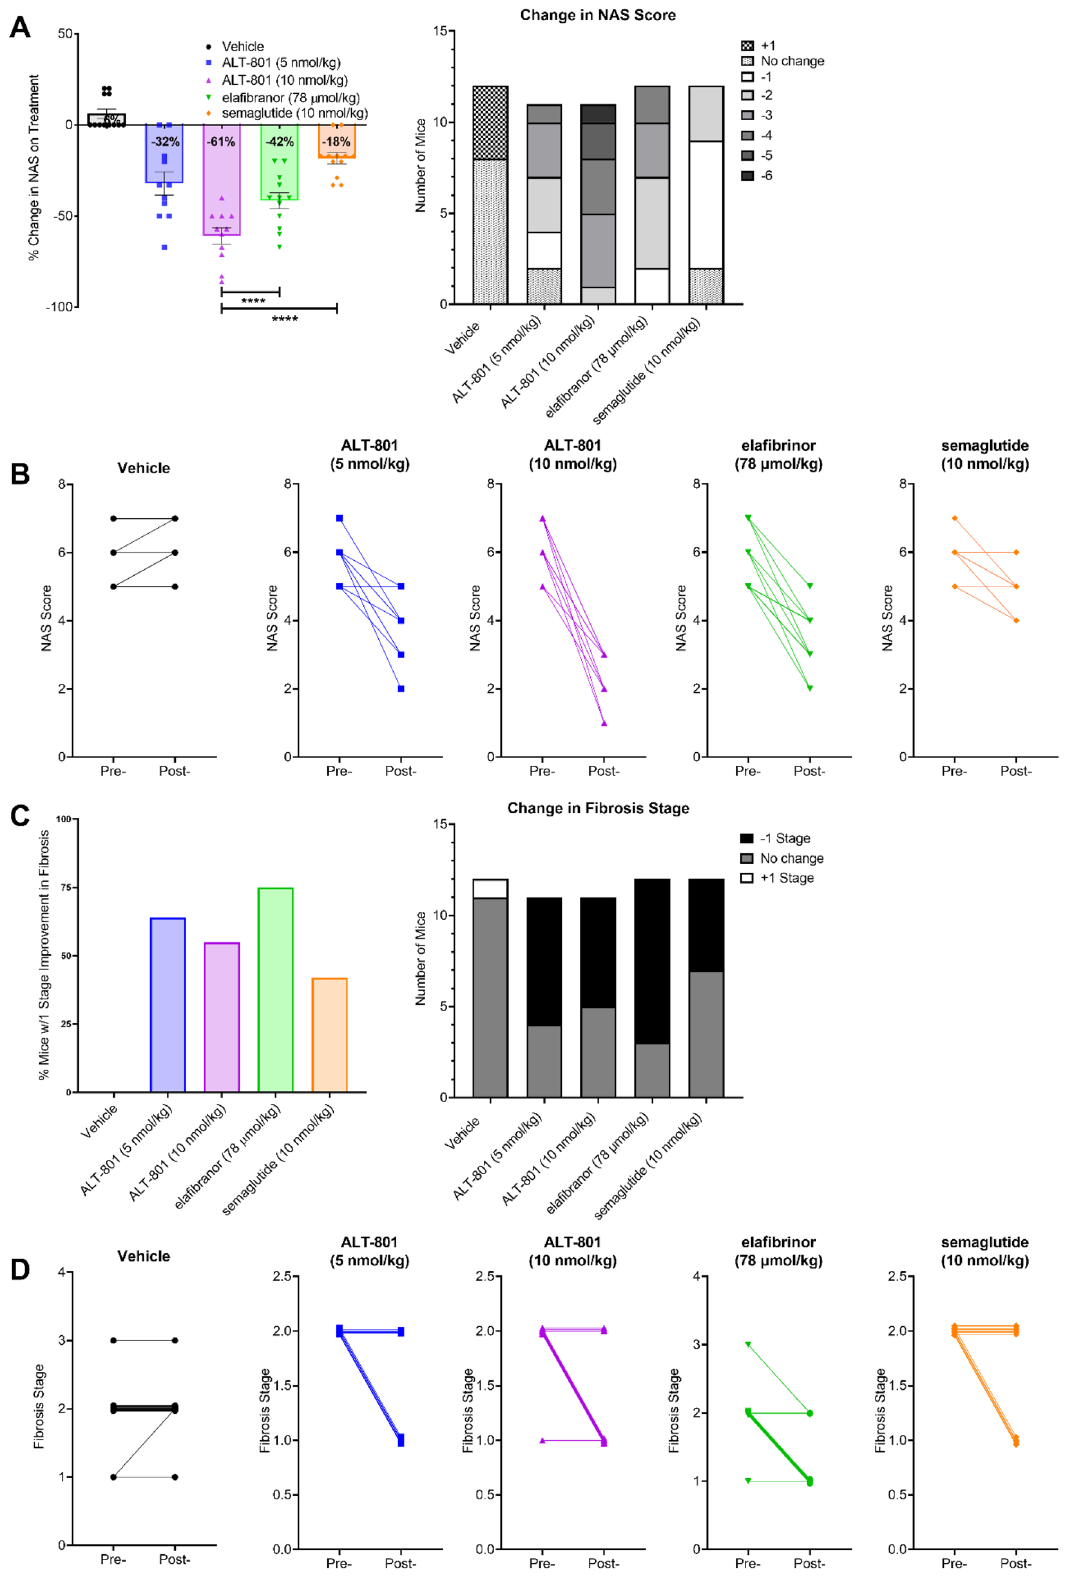
Figure 4. Treatment effects on NAFLD Activity Score and fibrosis stage. ( A ) Change in mean non-alcoholic fatty liver disease activity score (NAS). Significance is vs. ALT-801 10 nmol/kg. ( B ) Change in individual NAS. ( C ) Change in mean fibrosis stage. ( D ) Change in individual fibrosis stages. The points at each scoring step are slightly shifted to allow visual separation of the animals. This presentation is only for visualization purposes and does not reflect any difference in score. **** p <